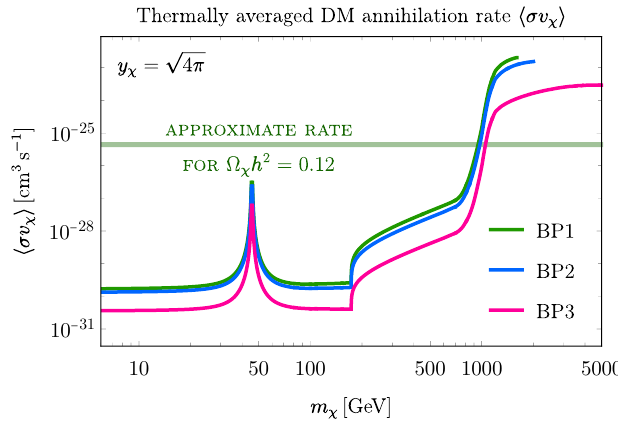
Figure 15 . Total dark matter annihilation rate as a function of m χ < m ψ in all three benchmarks. √ Results are displayed for y χ = 4 π , at the upper limit of perturbativity. The line at h σv χ i ≈ 4.4 × 10 − 26 cm 3 s − 1 estimates the annihilation rate producing the observed relic density in a standard cosmological history